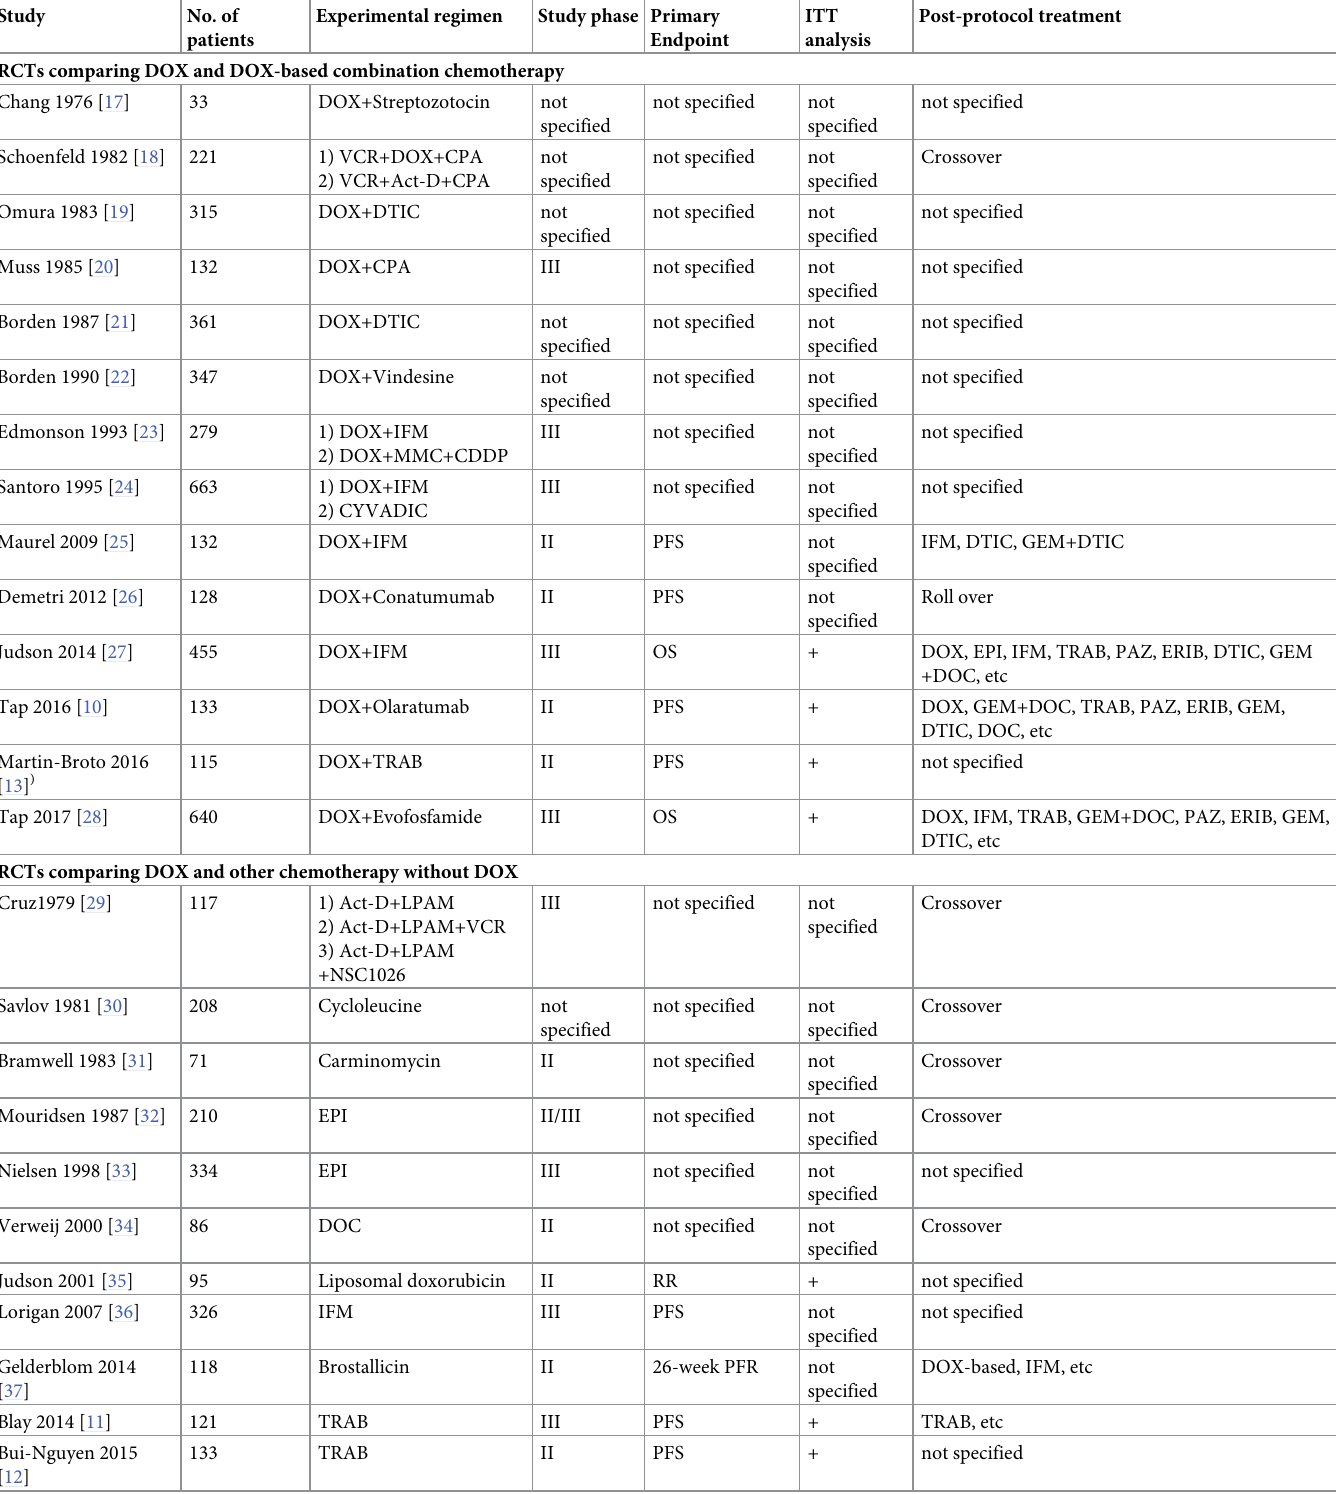
Table 2. Description of